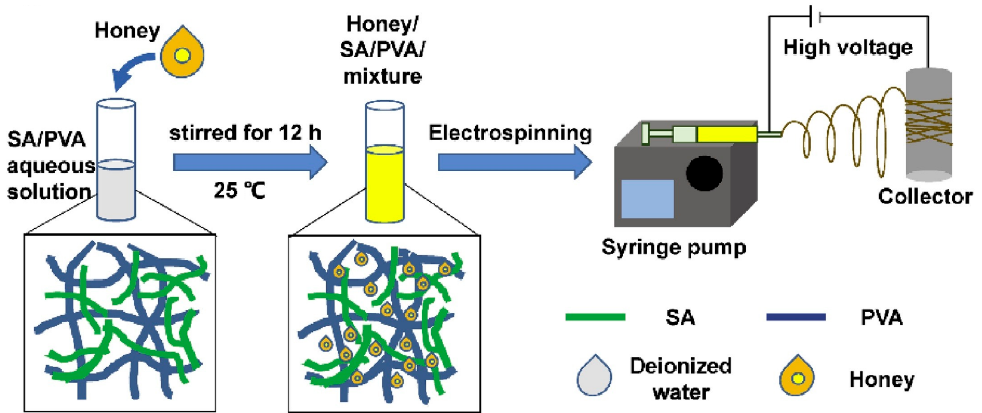
Figure 7. Schematic illustration of the solution preparation and electrospinning process. Reproduced from [57] with permission from Elsevier.